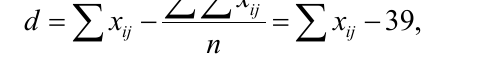
Table 2 uses the following calculation formula: